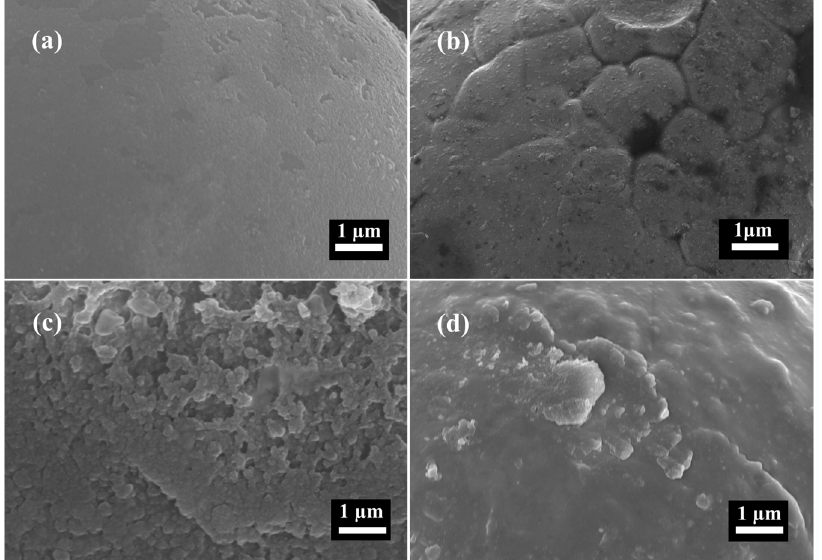
Figure 1. SEM images of ( a ) the original powder and the powders treated by ( b ) 0.5 wt.% H 3 PO 4 - ethanol solution, ( c ) 2 wt.% sodium silicate-aqueous solution, and ( d ) 0.5 wt.% H 3 PO 4 -ethanol solution followed by 2 wt.% sodium silicate-aqueous solution.